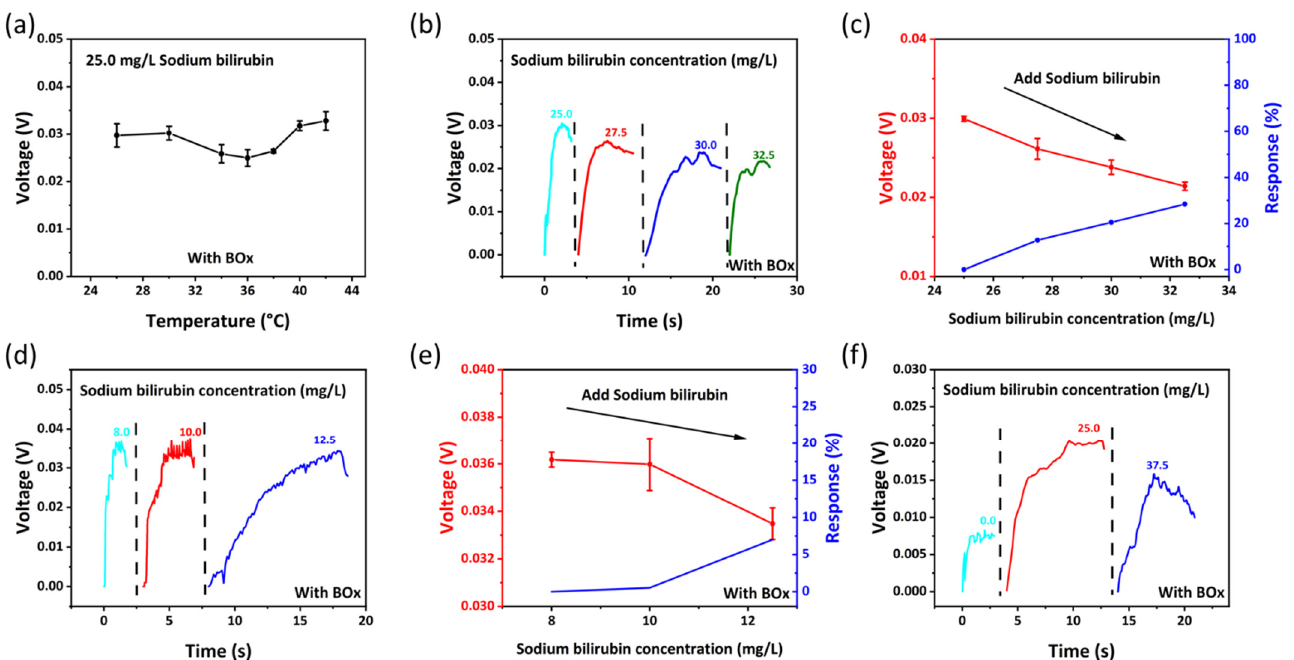
Figure 5. ( a ) The output of the device at different temperatures. ( b , c ) The biosensing behavior and response of the device against small lactate concentration change. ( d , e ) The limit of detection of the device. ( f ) The biosensing behavior of the device in mixed solution (approximately urine).